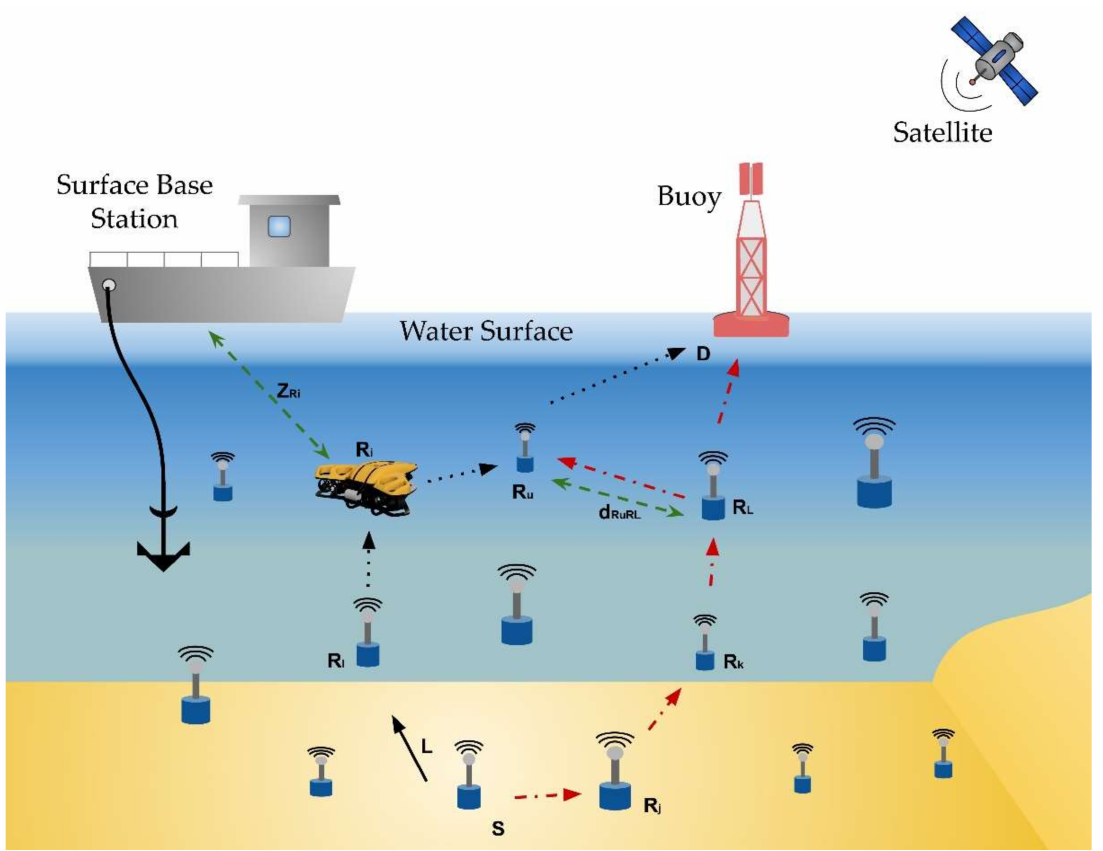
Figure 5. MIoT architecture based on a data transfer